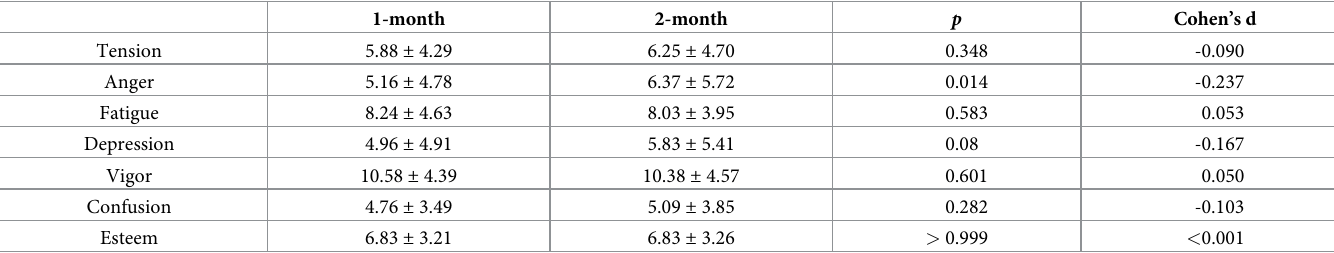
Table 2. Descriptive results of mood of athletes in closed-loop management ( M ± SD